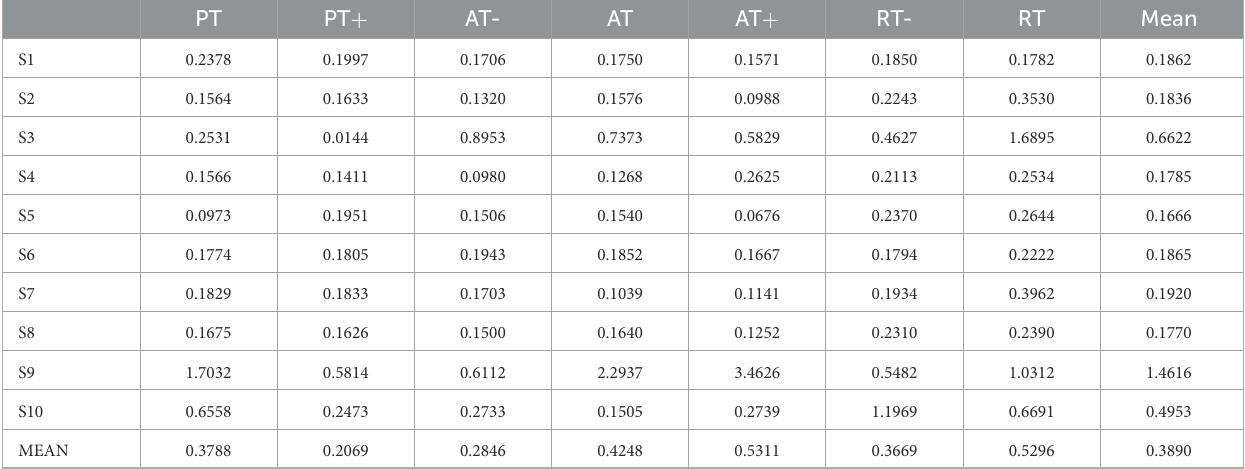
TABLE 2 MAE of 10 participants in seven experimental